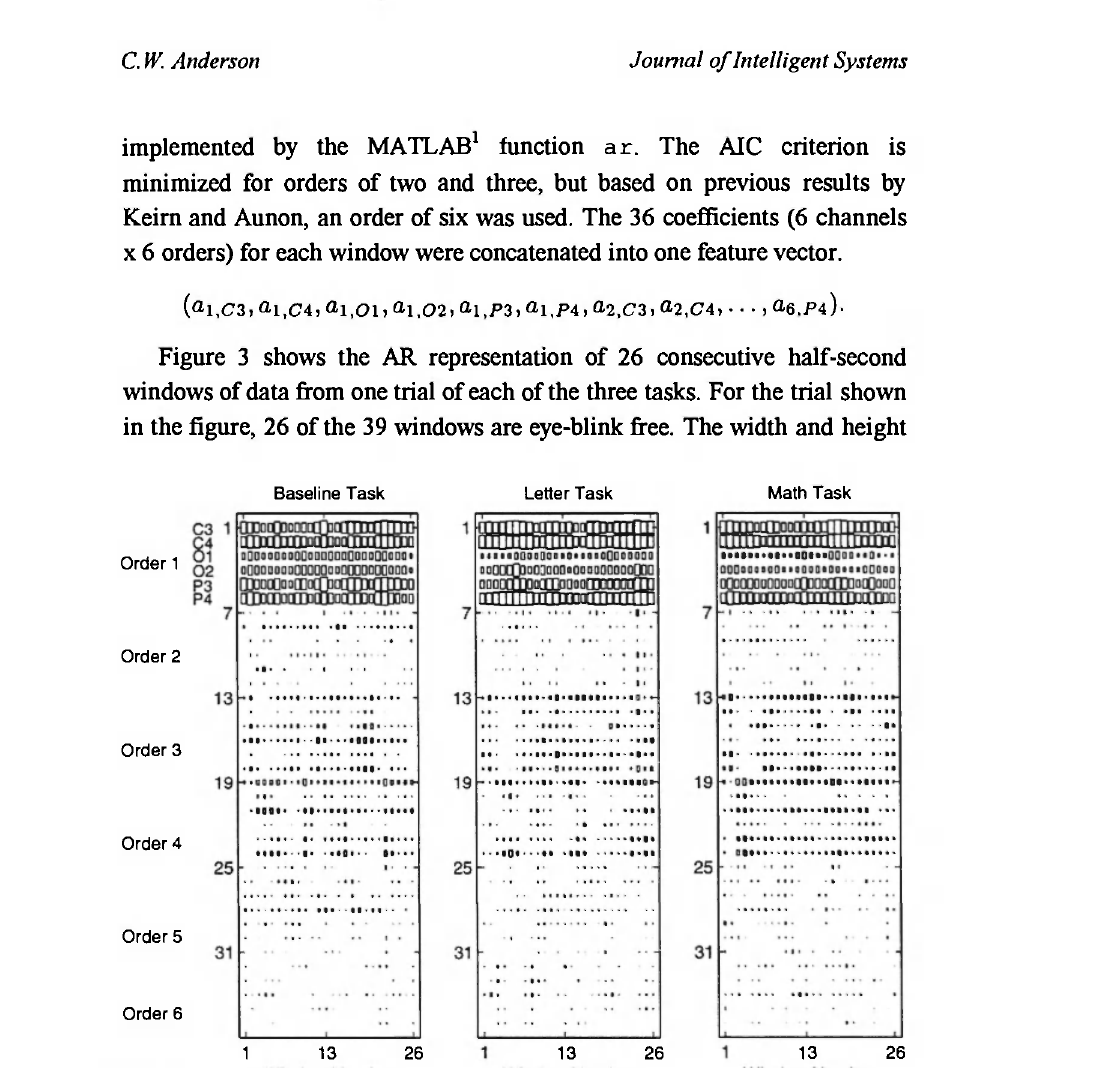
AR representation of eye-blink free windows from one trial of data from one subject performing each task. Positive coefficients are shown as filled boxes and negative coefficients are unfilled. The width and height of a box is proportional to the magnitude of the corresponding coefficient. The highest magnitude coefficients across tasks are the first order